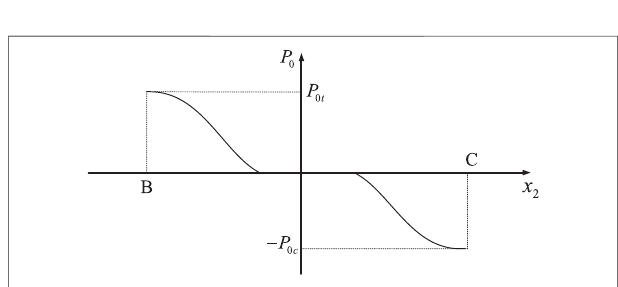
FIGURE 4 | Distribution of axial force alongside the BC section of